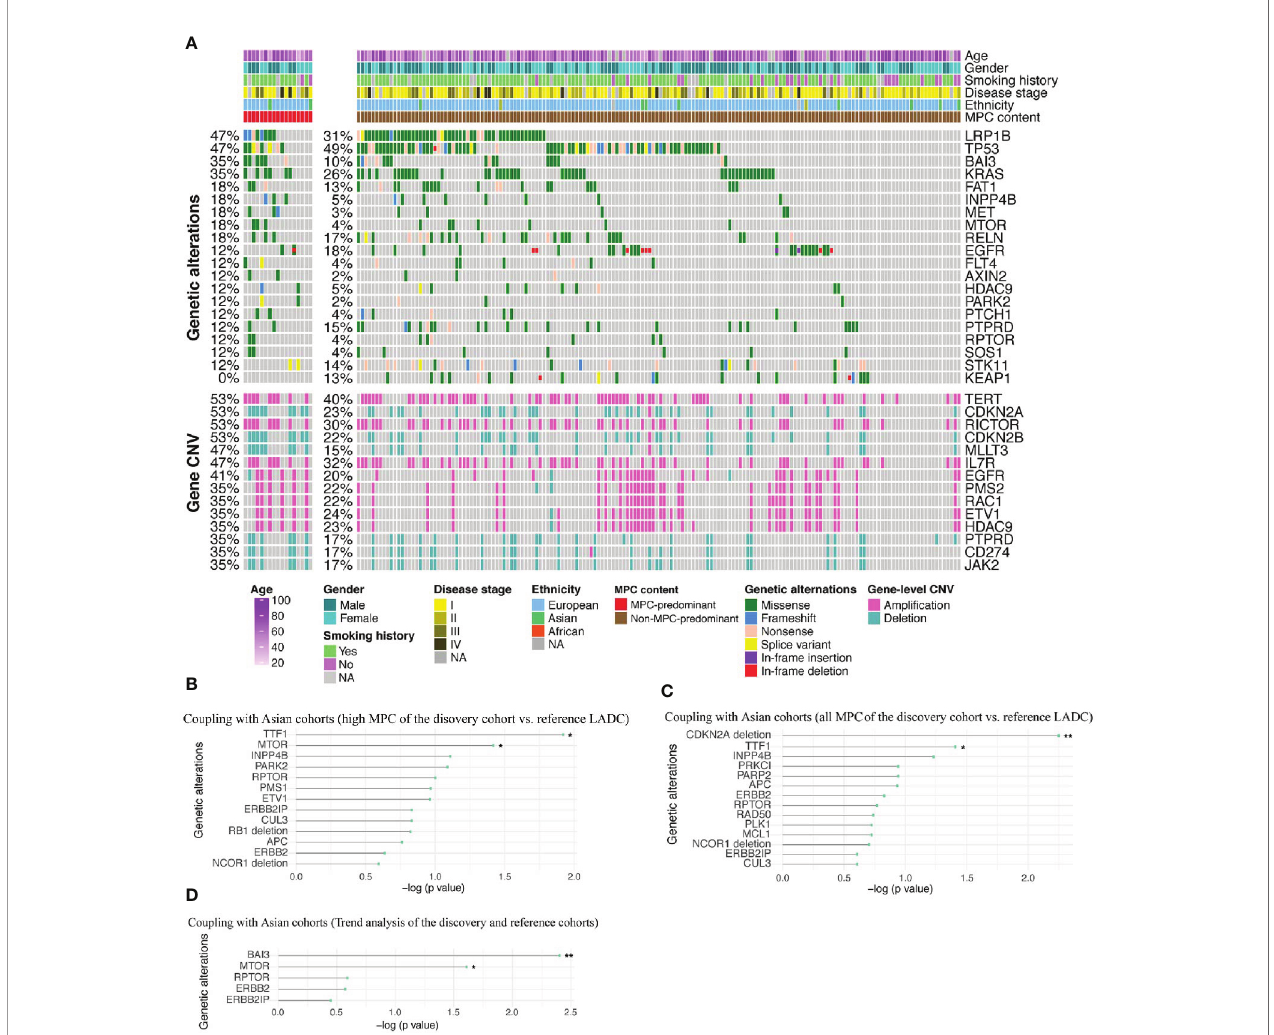
FIGURE 3 | The MPC-associated genetic alterations that can be con fi rmed by the validation cohort. (A) Genetic alteration pro fi le of the validation cohort with either MPC-predominant (MPP) tumors (left panel) or other histological subtypes (right panel). (B – D) The cross-validated MPC-associated genetic changes by coupling the P values from the validation cohort with the discovery/reference cohorts that underwent different analysis: comparing MPC-dissected samples from high MPC tumors of the discovery cohort with reference cohort (B) , comparing all MPC-dissected samples of the discovery cohort with reference cohort (C) , and Jonckheere ’ s trend analysis of mutation frequency ranking from dissected samples from high MPC tumors, dissected samples from low MPC tumors, the matched non-MPC dissected samples to reference LADC samples (D) . *p < 0.05, **p <